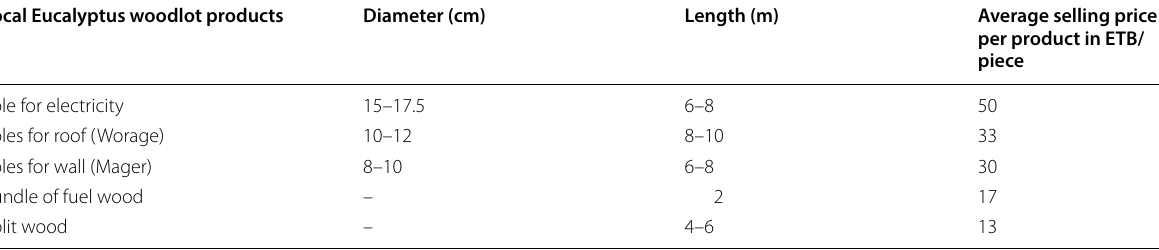
Table 3 Size classes of local Eucalyptus product assortments Local Eucalyptus woodlot products Diameter (cm) Length (m) Average selling price